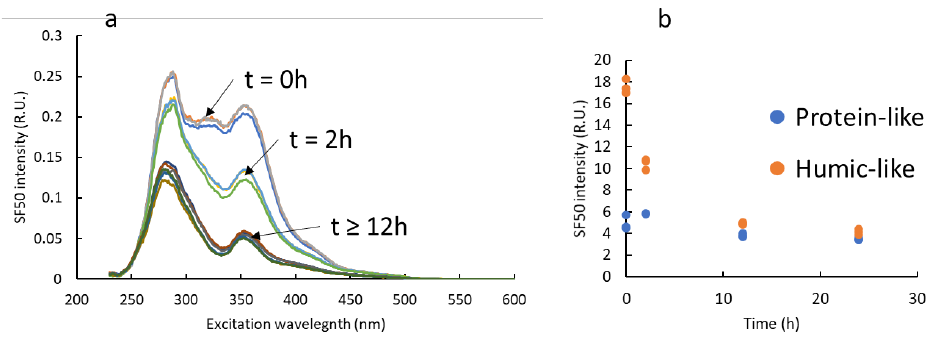
Figure 8. Synchronous fluorescence spectra of protein-like substances and humic-like substances ( a ) and evolution of the protein-like and humic-like SF50 intensities during the photolysis experiment A (run in triplicate) ( b ).